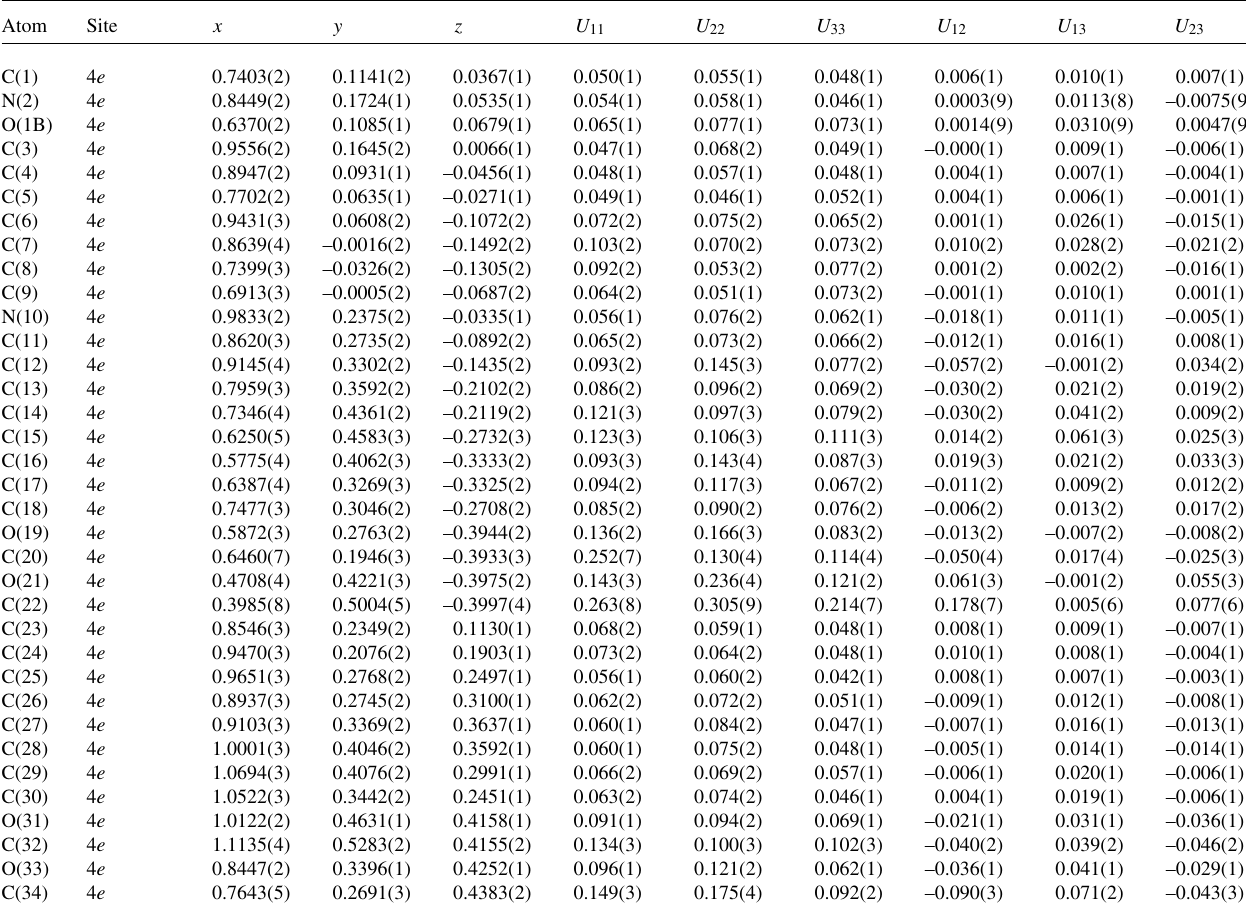
Table 3. Atomic coordinates and displacement parameters (in Å 2 )